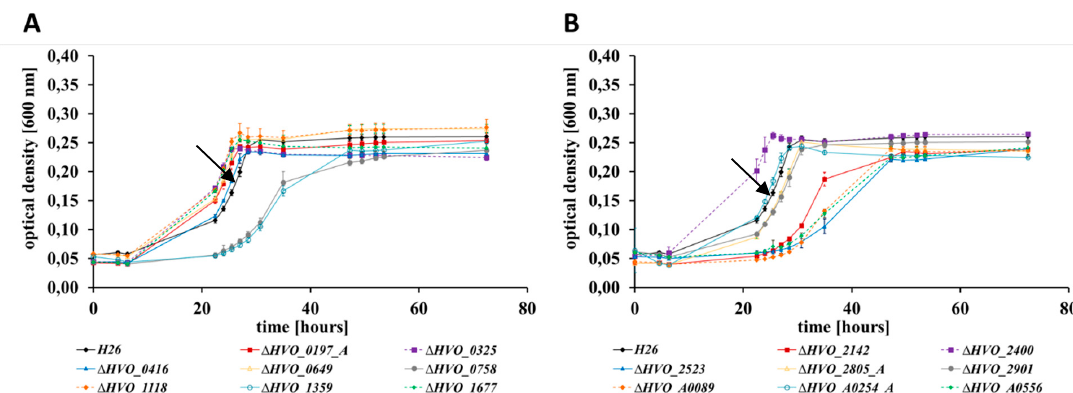
Figure 3. Growth curves of the parent strain H26 (black) and 16 deletion mutants (in color) grown in synthetic medium with glycerol as carbon source. ( A ) Parent strain H26 (black) and deletion mutants ∆ 0197_A (red), ∆ 0325 (purple), ∆ 0416 (dark blue), ∆ 0649 (yellow), ∆ 0758 (grey), ∆ 1118 (dark green), ∆ 1359 (light blue), ∆ 1677 (light green). ( B ) Parent strain H26 (black) and deletion mutants ∆ 2142 (red), ∆ 2400 (purple), ∆ 2523 (dark blue), ∆ 2805_A (yellow), ∆ 2901 (grey), ∆ A0089 (dark green), ∆ A0254_A (light blue), ∆ A0556 (light green). The wild-type is indicated by black arrows.